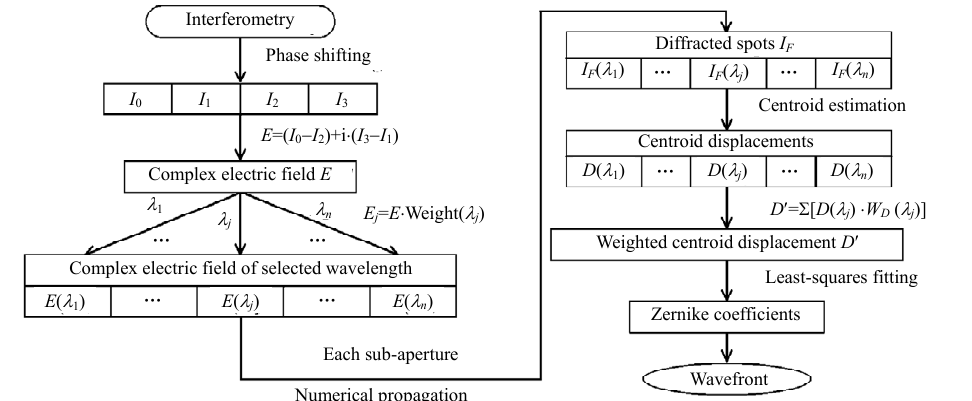
Fig. 1 Flowchart of MWCW data processing